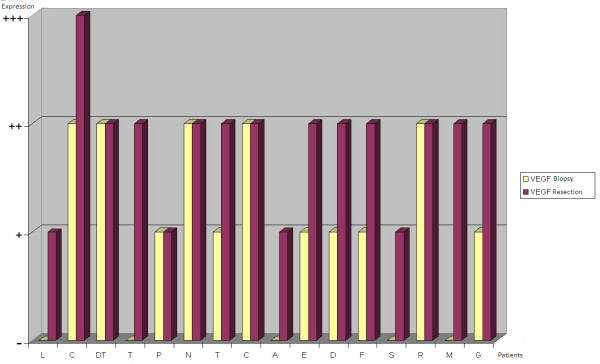
Changes in VEGF expression after neoadjuvant chemotherapy are compared for each patient.